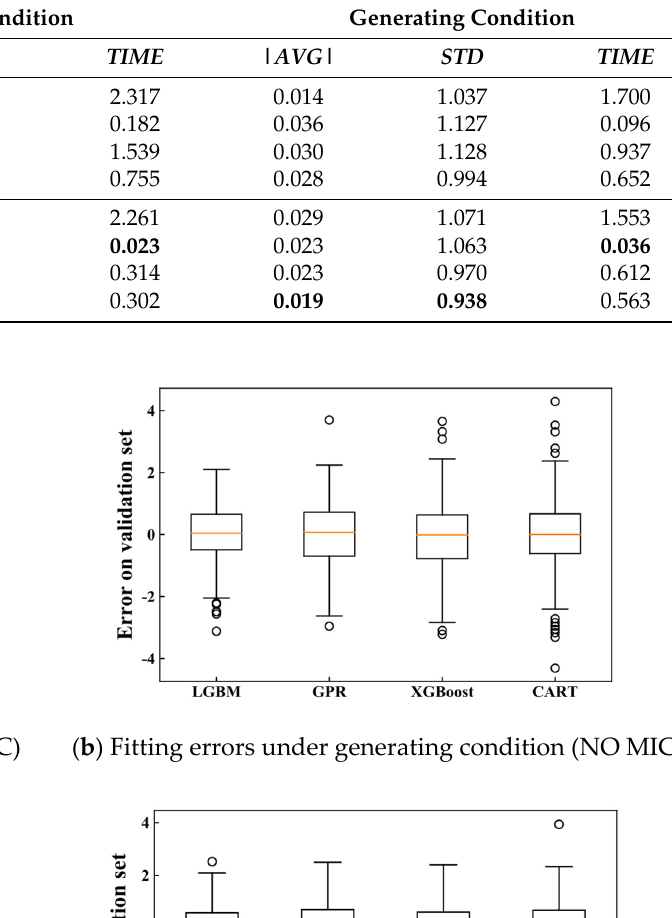
Table 2. Fitting errors of healthy models.